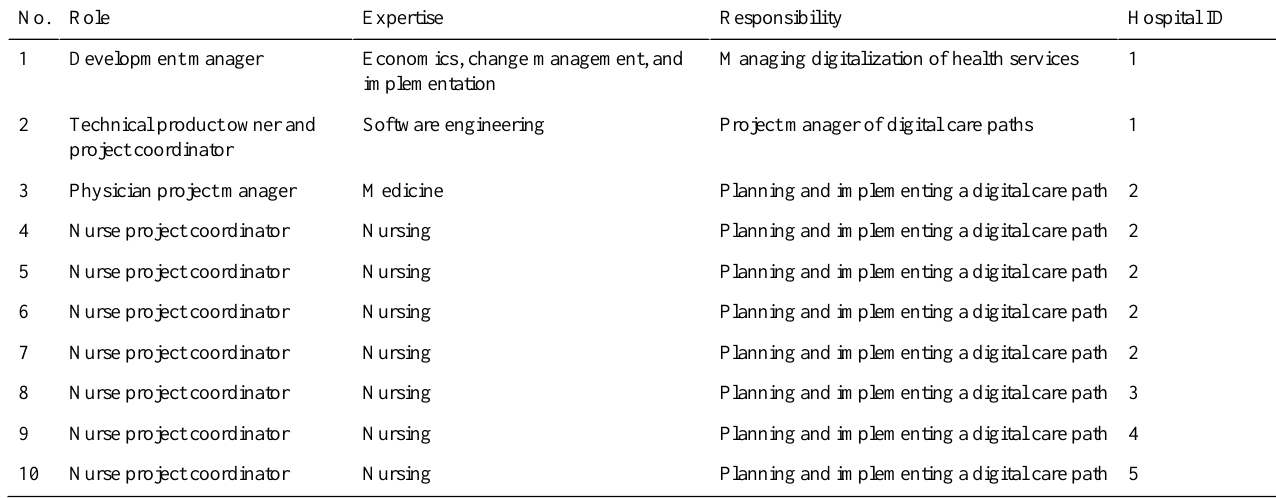
Table 2. Details about the study